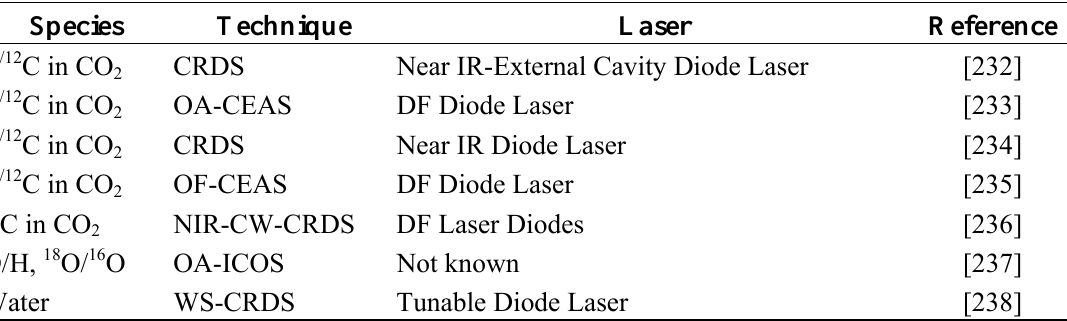
Table 4. Isotope studies with